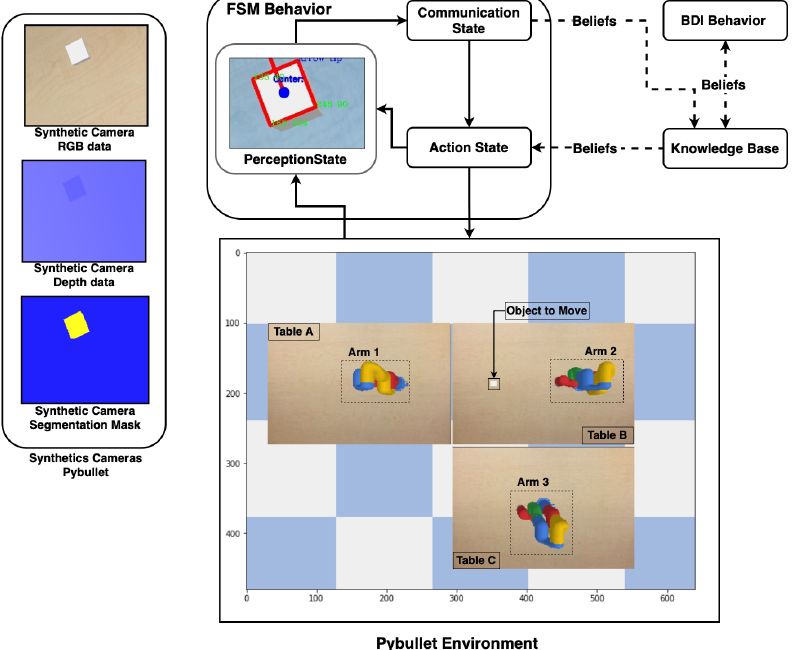
Figure 5. Diagram of the two behaviors inside each of the SPADE agents, including their interactions with each other and the environment: solid lines represent the transitions between states in the FSM behavior, while dashed lines represent information exchange among the agent’s behaviors, through the agent’s knowledge